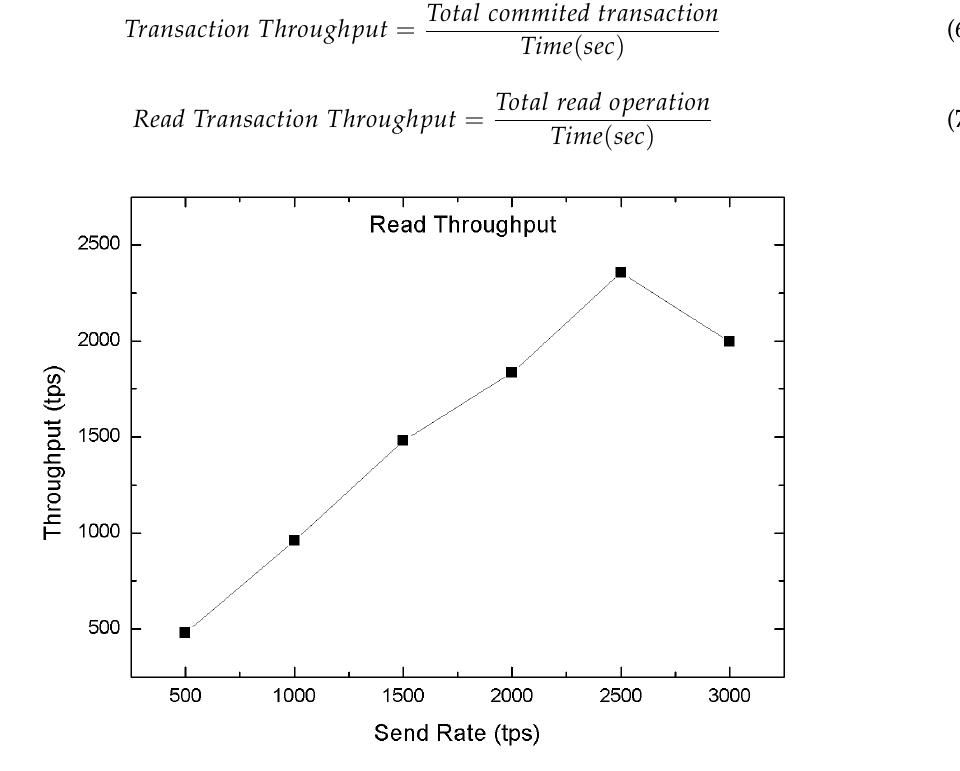
Figure 12. Read transaction throughput.